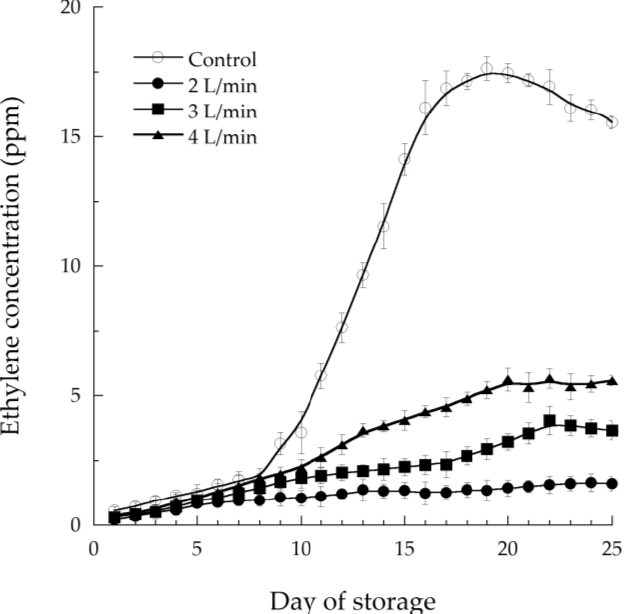
Figure 3. The dependence of ozone concentration on ( a ) oxygen flow rate; ( b ) discharge time.